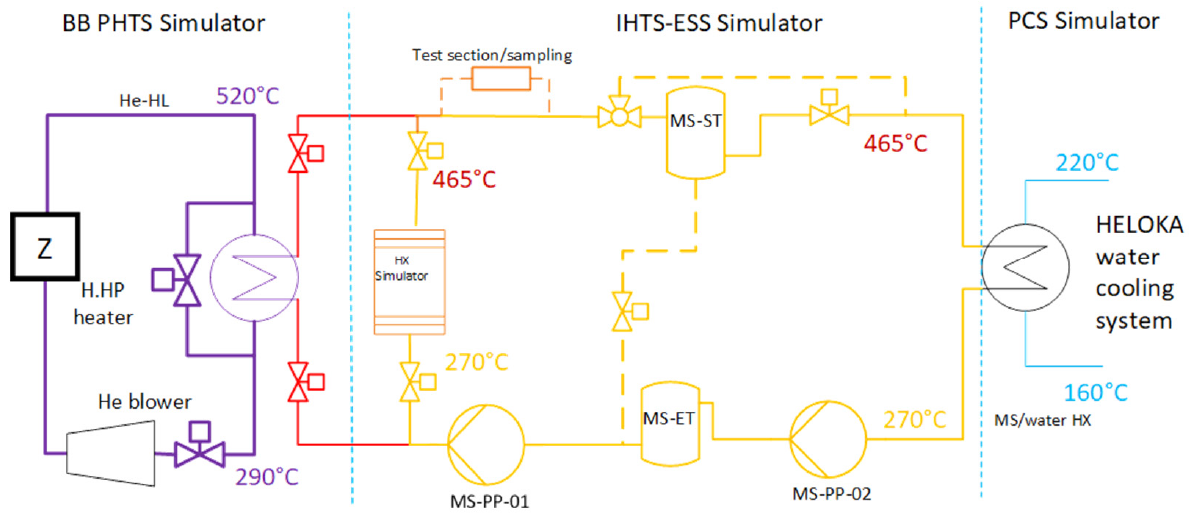
Figure 3. Schematic diagram of HELOKA ‐ US.